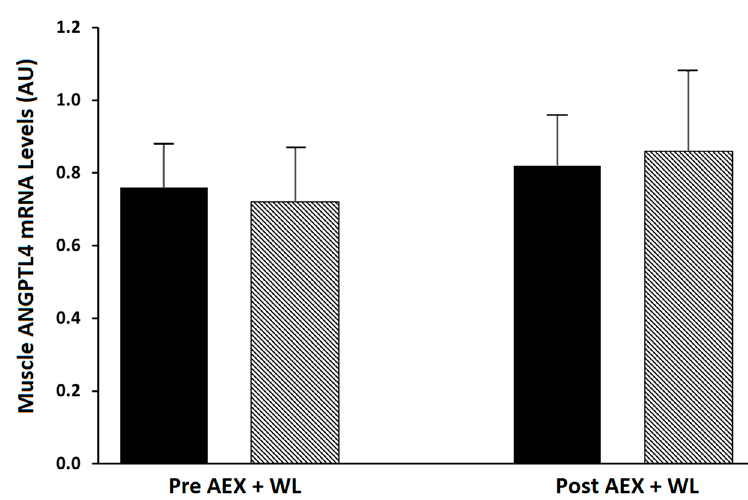
Figure 1. Skeletal muscle angiopoietin-like protein 4 (ANGPTL4) levels during basal (solid) and insulin-stimulated (striped) conditions pre aerobic exercise + weight loss (AEX + WL) and post AEX + WL ( n = 35).